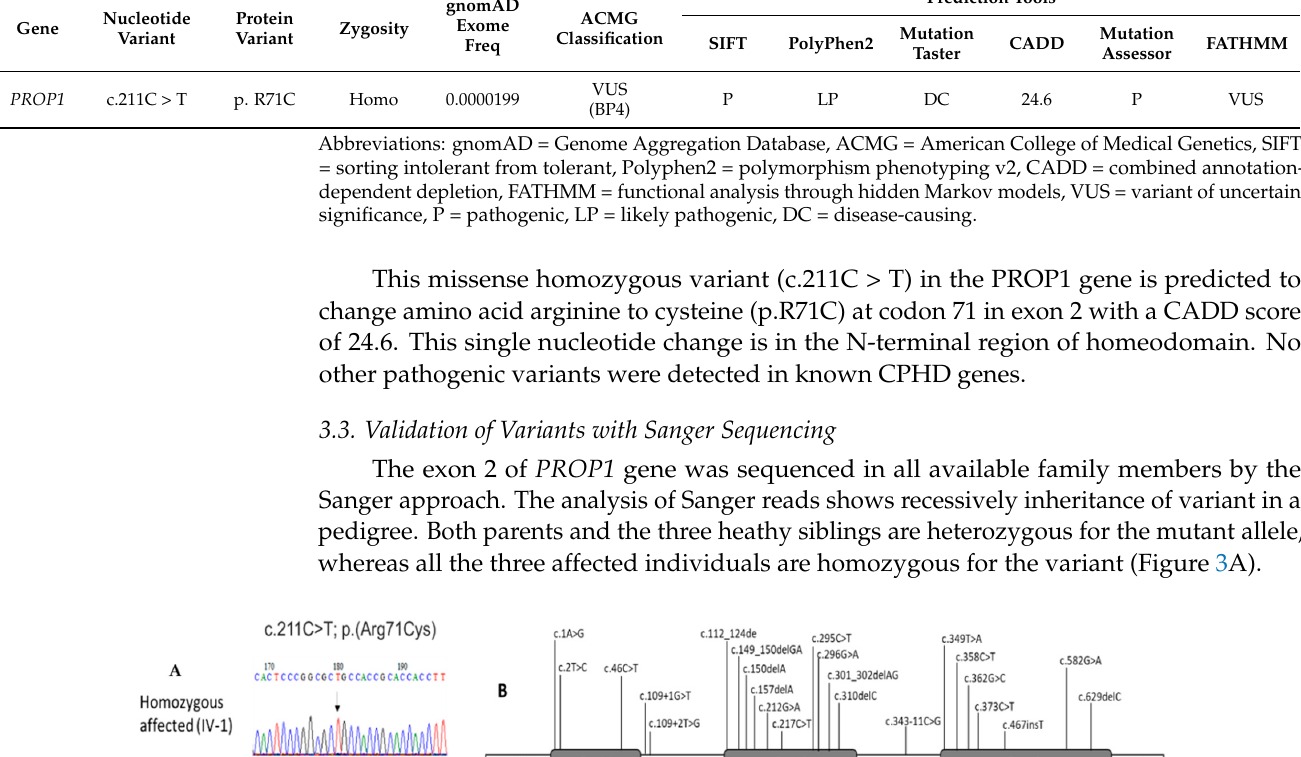
Table 2. Common pathogenic variant identified by WES and their interpretation with several bioinformatic analysis tools. Figure 2. Variant filtration scheme for the exome data of two affected individuals. A single shared homozygous variant has been detected using this scheme.